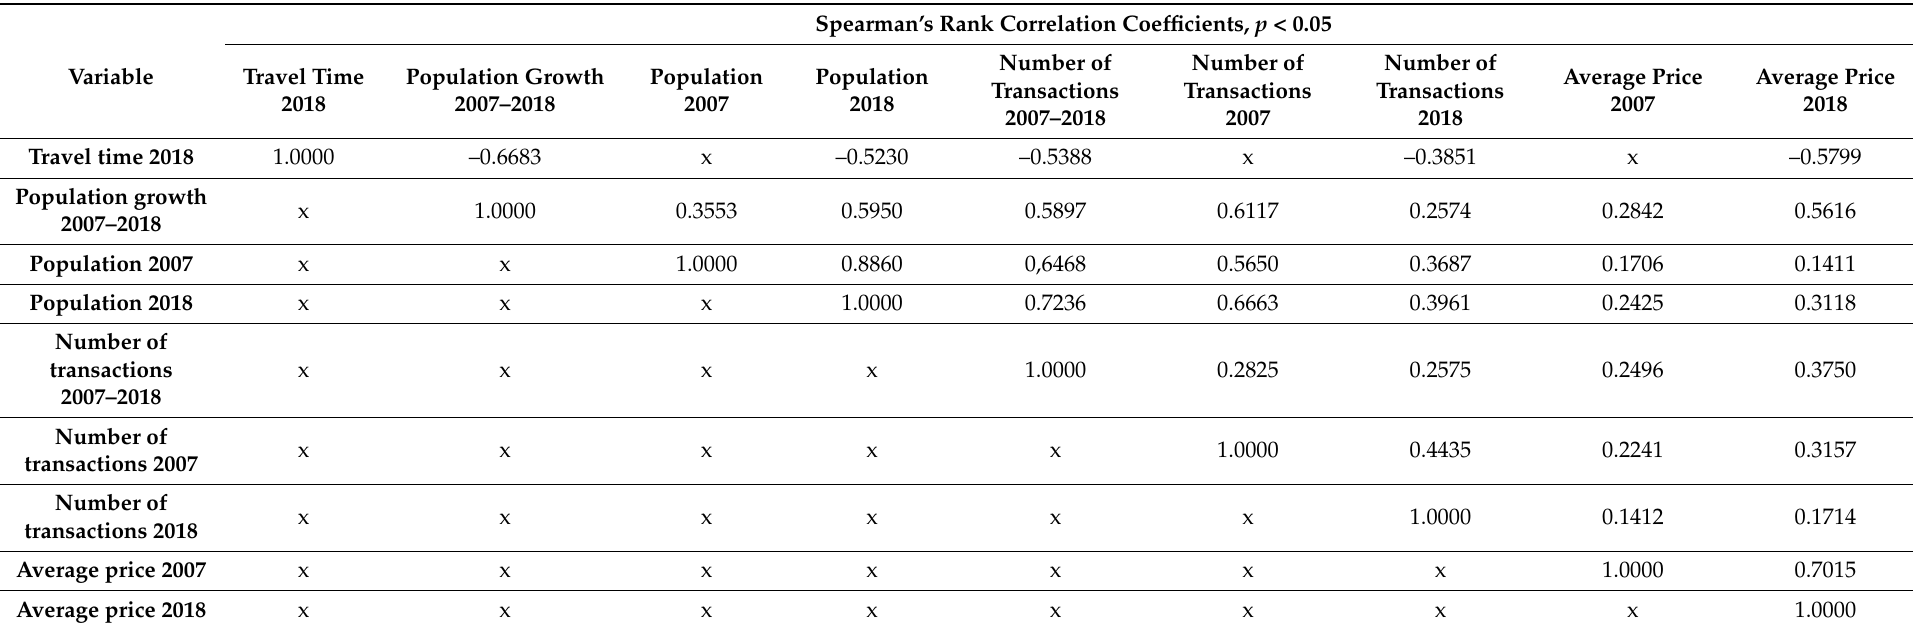
Table 2. Spearman’s rank correlation coefficients for the analyzed